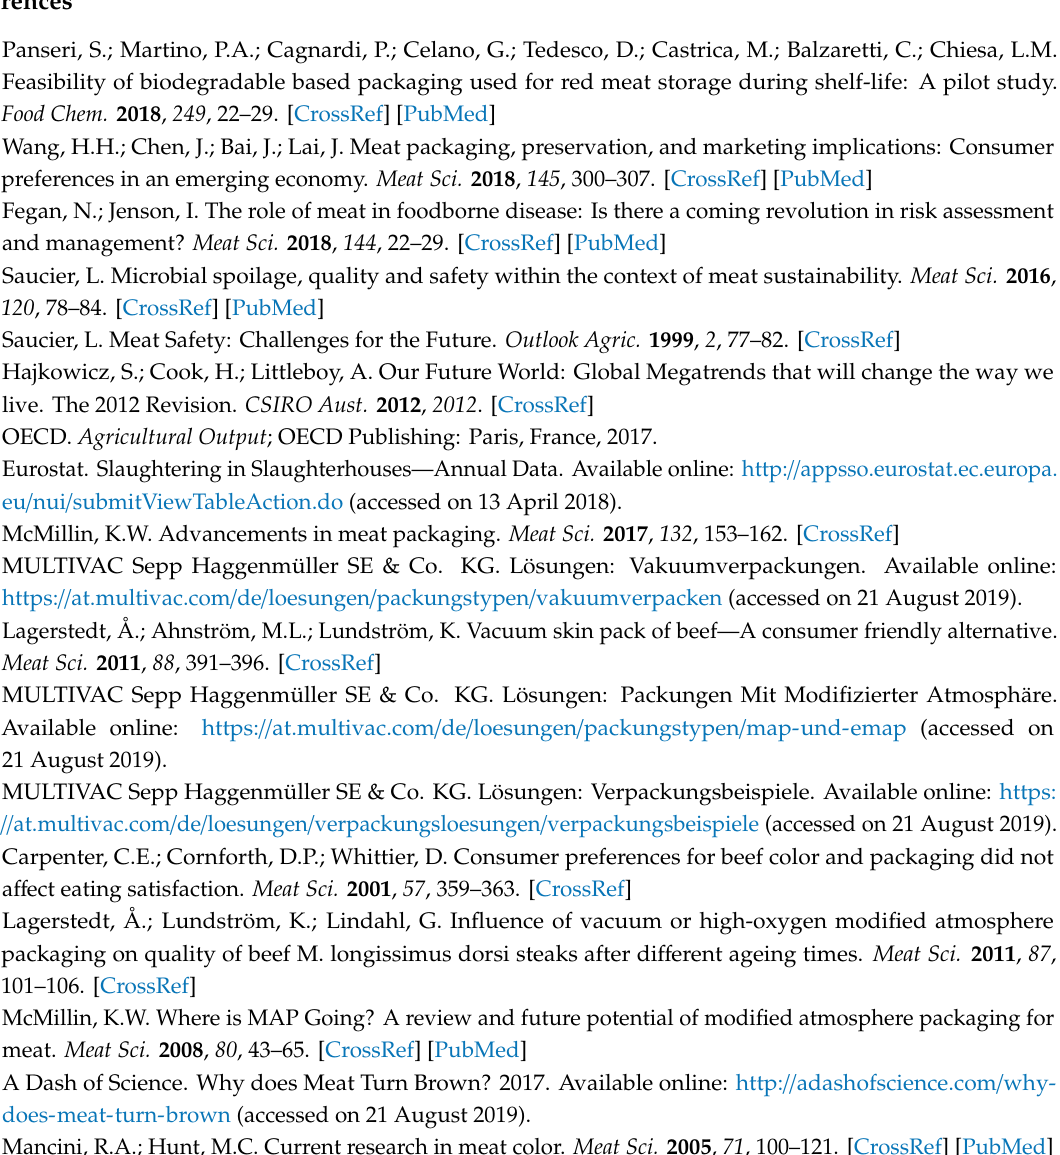
Figure A4. Average color distance (∆E) in BioMAP and MAP in ( A ) ground meat (GM) and ( B ) pork loin (PL) over a meat age of 27 and 38 days, respectively.